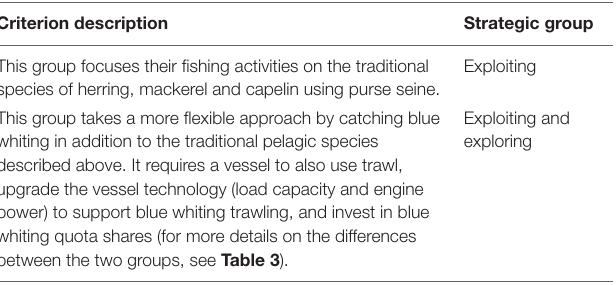
TABLE 1 | Classification criterion for the separation of the sample into strategic